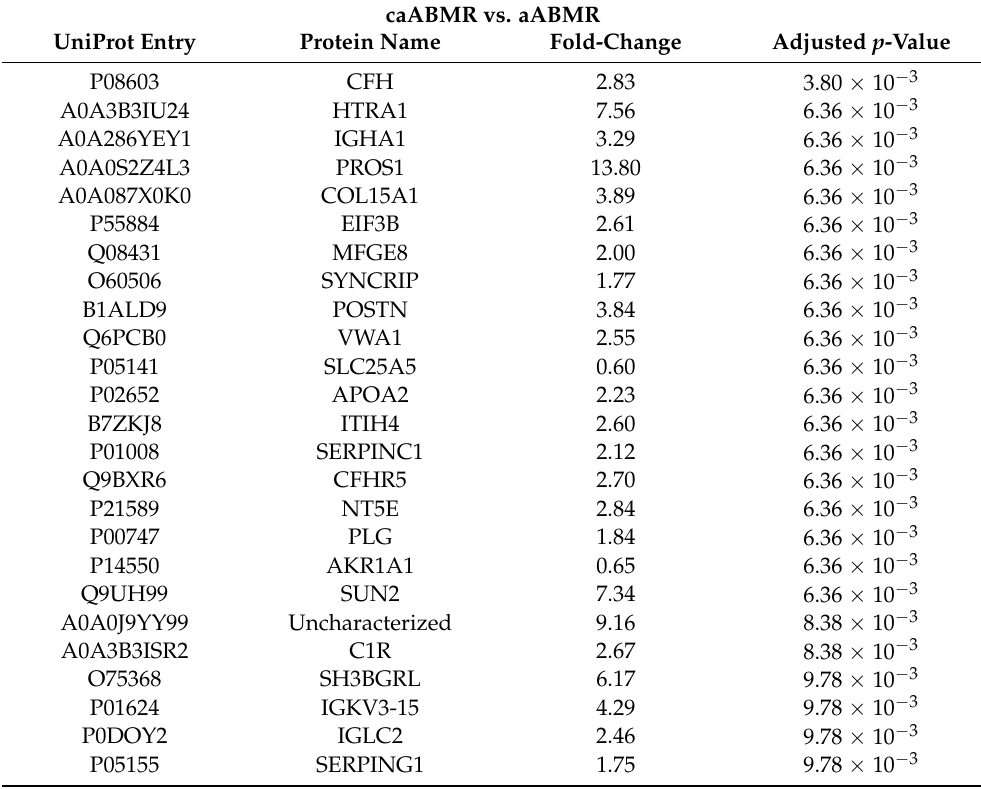
Table 4. Top-25 proteins differentially represented in chronic active ABMR compared to active